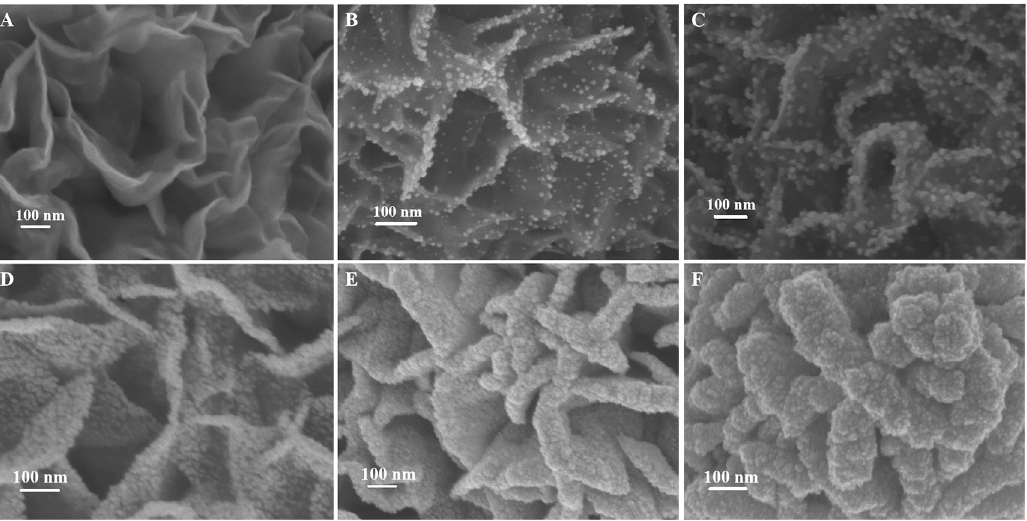
Figure 3: Scanning electron microscope (SEM) images of molybdenum disulfide (MoS 2 )-based substrate. SEM images of (A) pyramid Si (PSi)/molybdenum disul fi de (MoS 2 ) multiscale cavity (MSC) with magni fi cation; (B – F) PSi/MoS 2 /Au MSC with different reaction times of HAuCl 4 at 1, 2, 3, 4, and 5